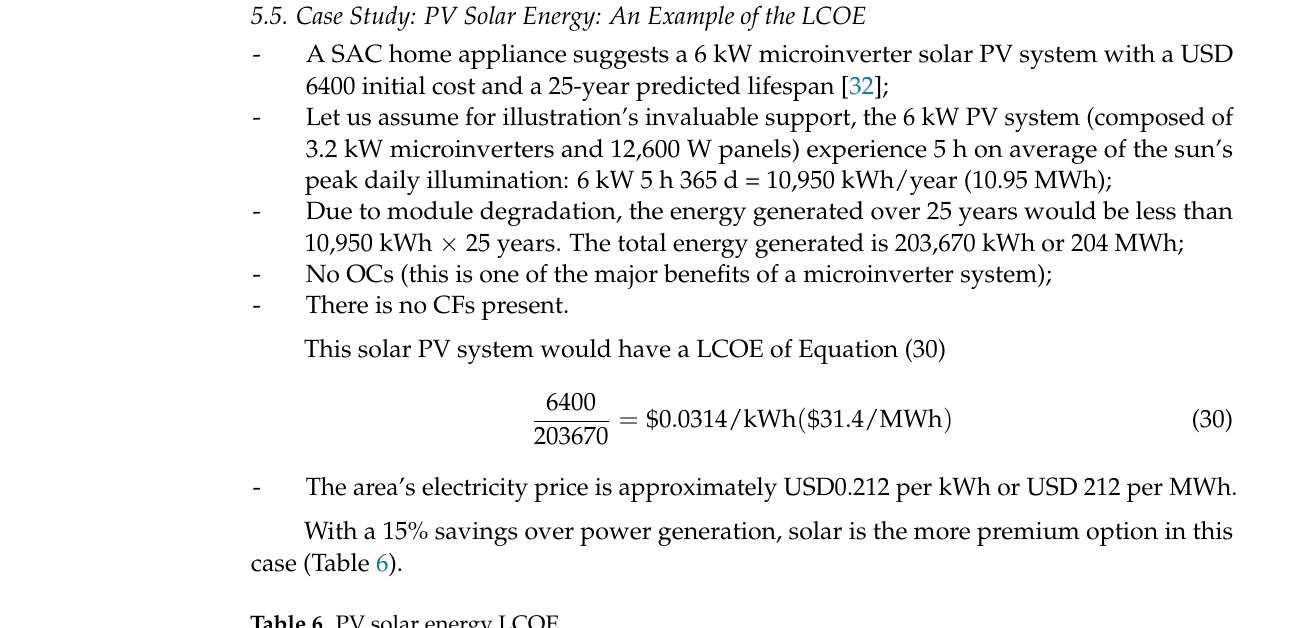
Table 6. PV solar energy